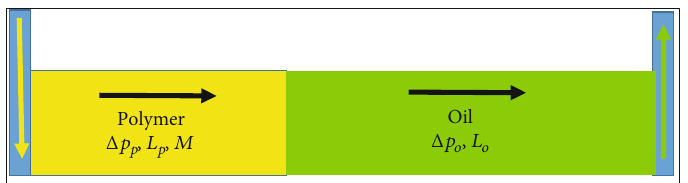
Figure 2: Simple linear, piston-like displacement of oil in a single layer.